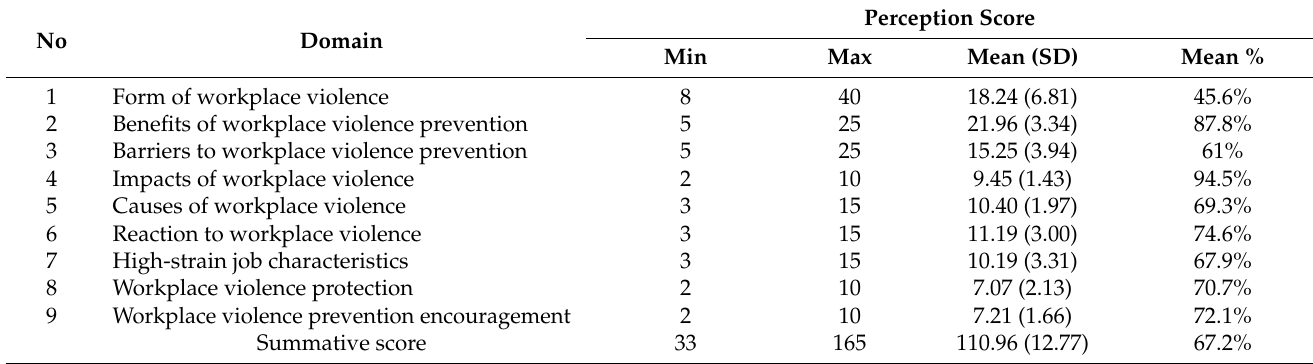
Table 2. Mean percentage of perception towards WPV prevention domain in PPWVP ( n = 162).